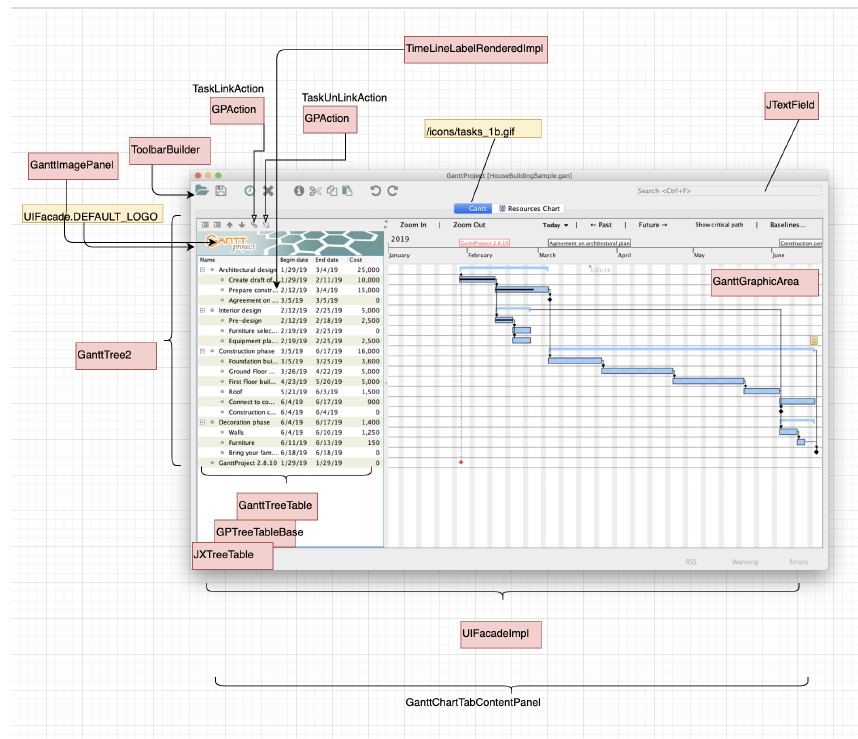
Figure 4. This type of diagram with screenshots of the application labeled with the name of the main classes that implement some of the components can be of great help for new